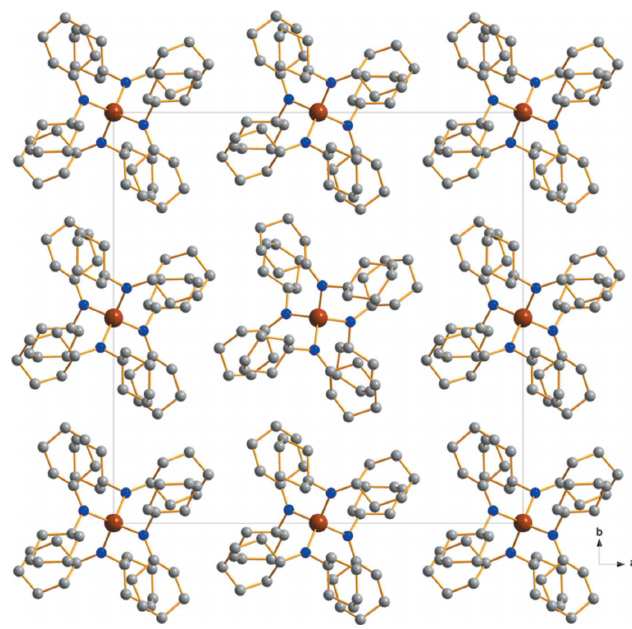
Figure 2 Aview along the c axis showing the packing of individual molecules in the crystal of 1 . No significant supramolecular features can be observed. Colour code: C grey, N blue, Zr brown spheres.